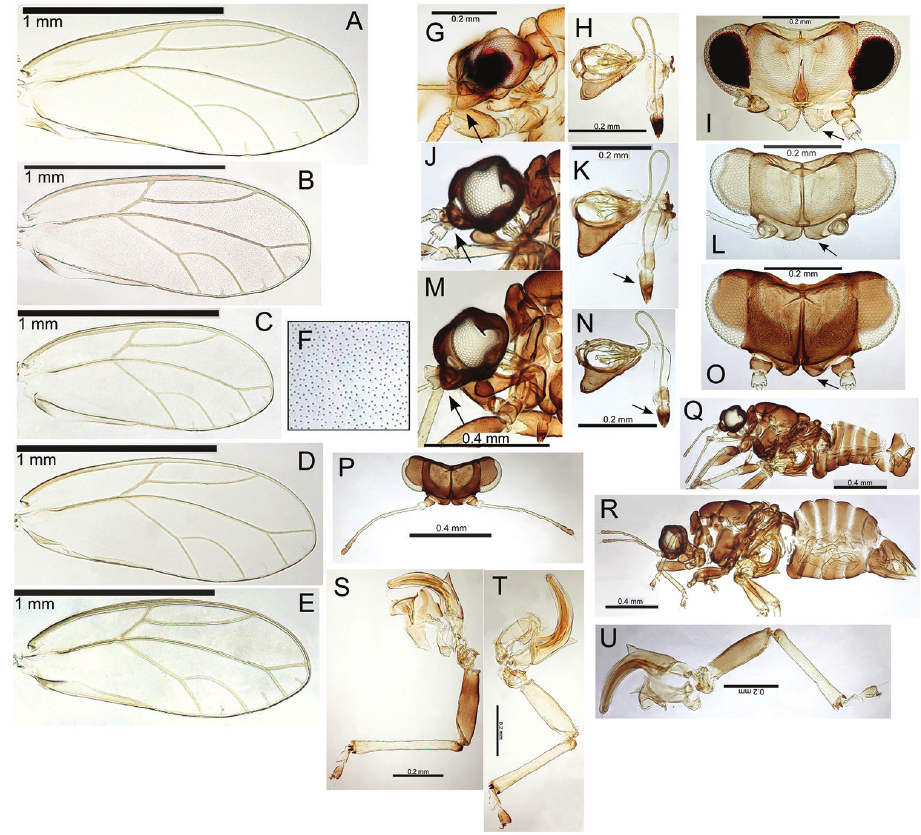
Figure 15. Pariaconus gracilis . A, B, C, D, E fore wing: A form gracilis (Waianae, Oahu) B form conconus (Koolau, Oahu) C form gracilis (Koolau, Oahu) D form gracilis (Molokai) E form gracilis (Maui) F detail of fore wing spinule density, form gracilis (Molokai) G, H, I form conconus (Koolau, Oahu): G head (uncleared ocular tissue) H proboscis I head (uncleared ocular tissue) J, K, L form gracilis (Aiea, Oahu): J head K proboscis L head M, N, O form gracilis (Maui): M head N proboscis O head P, Q, R form gracilis (Oahu): P head and antennae, Q male R female S, T, U hind legs: S form gracilis (Koolau, Oahu) T form conconus (Koolau, Oahu) U form gracilis (Maui).